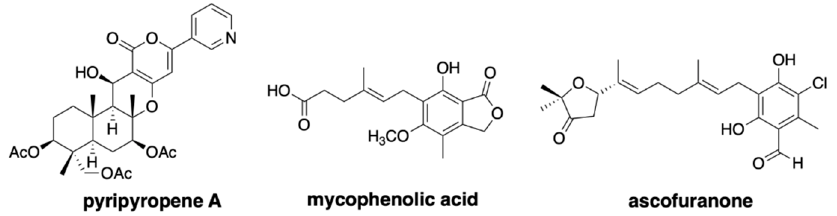
Figure 1. Representative bioactive fungal meroterpenoids.